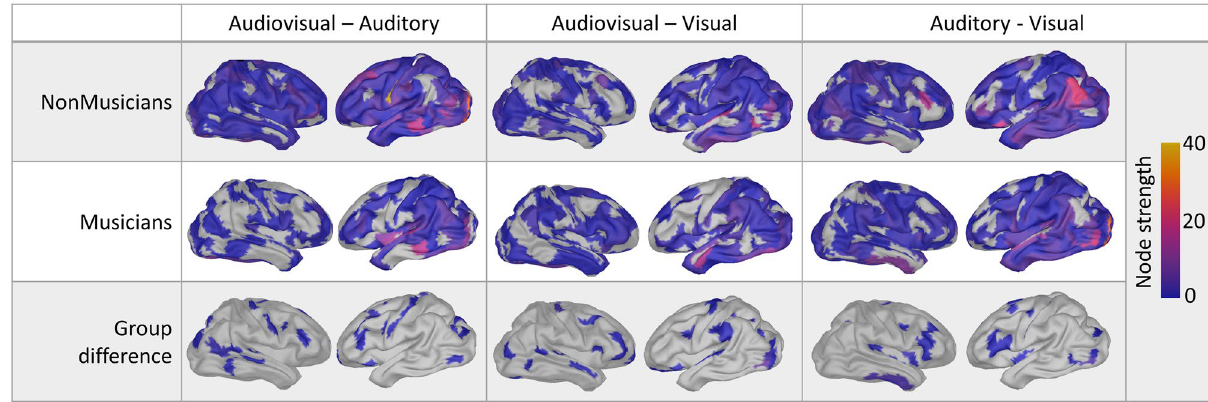
Figure 4. Node degree of between task-defined state of functional connectivity amongst the different sensory modalities and music related neuroplasticity: Node degree of the between-network connectivity projected on an average cortex, presented in a tabular form. First row contains results of non-musicians for each pair of modalities involved in the identification of statistical irregularities (i.e., audiovisual—auditory, audiovisual— visua, auditory-visual), second row presents results of musicians, while the third row presents the 2 × 2 interaction of condition × group, and hence, the effect of expertise related re-organization, for each pair of modalities. The color scale indicates node degree: number of multilinks (edge-to-edge correlation amongst the edges of the network of each independent modality) that involve these cortical